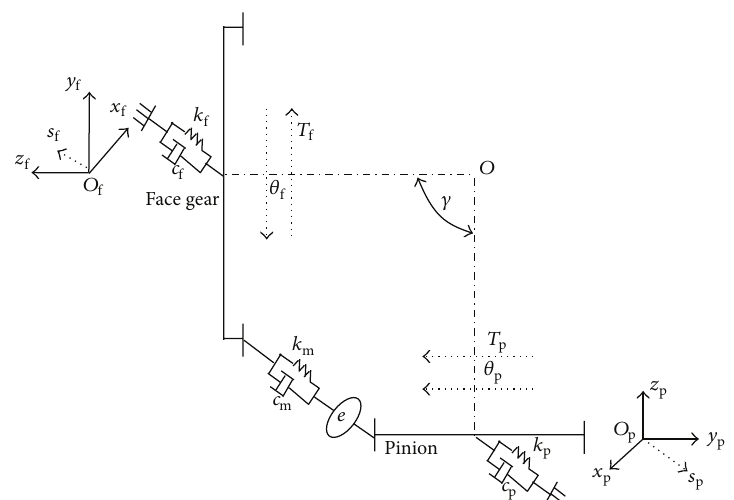
Figure 5: A four-DOF dynamic model of face gear drives.